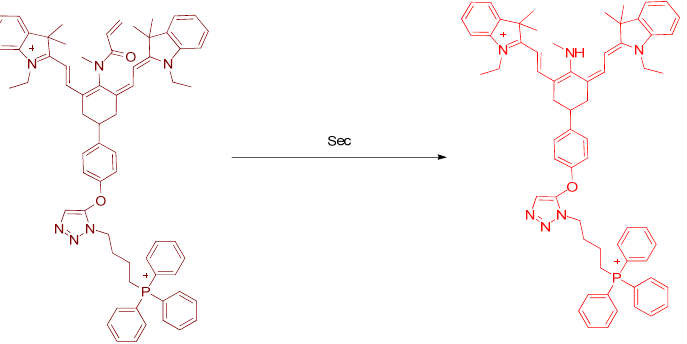
Figure 50. Selenocysteine detection using Mito–Cy–Sec , a cyanine based dye by Luo et al. Zhang et al. reported BF–1 , a probe that has a cleavable 2,4–dinitritro phenyl– group;